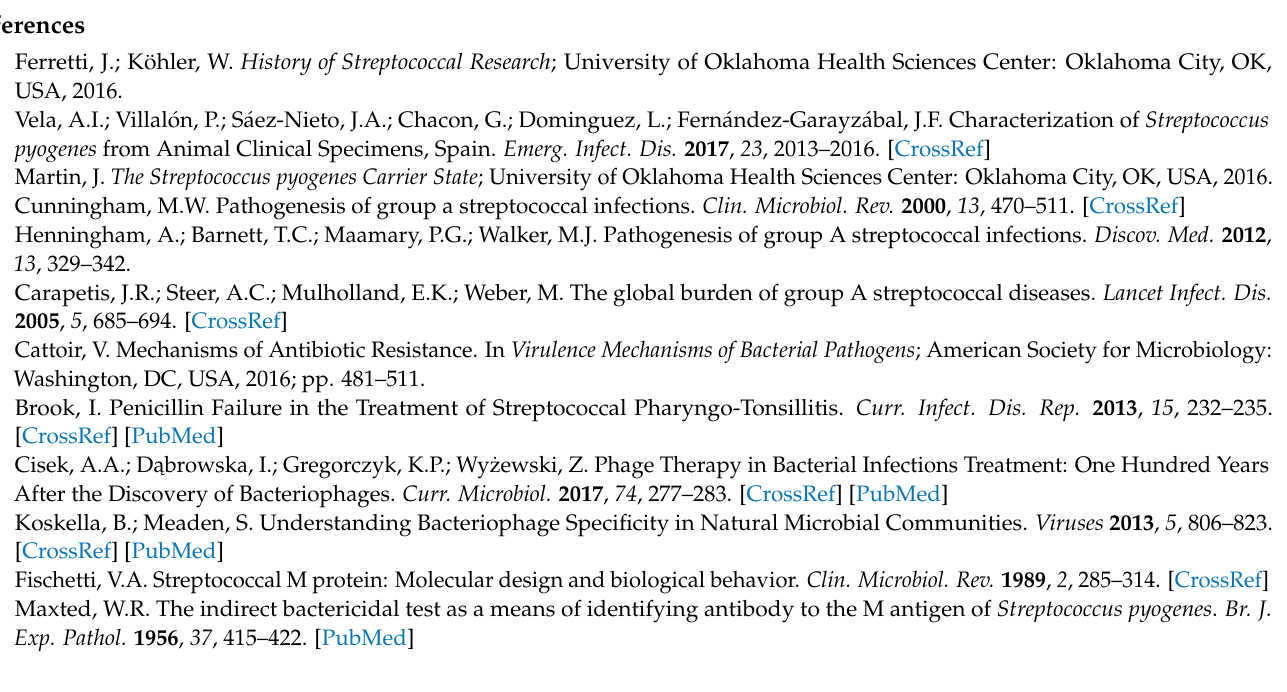
whole genomes; Figure S2: Growth curves of WT ATCC 12202 (left), WT SF370 (right) compared to three potential Phage A1 lysogens each; Figure S3: (A) Phage A1 plaquing on SF370 in the absence and presence of hyaluronidase in growth medium. Mean values ± SD from three independent experiments are shown. (B) Alignment of acquired spacer sequences in WT SF370 (top) or SF370 ∆ hasA (bottom) phage survivors to the Phage A1 genome highlighted in red on the dark yellow bar, marked by